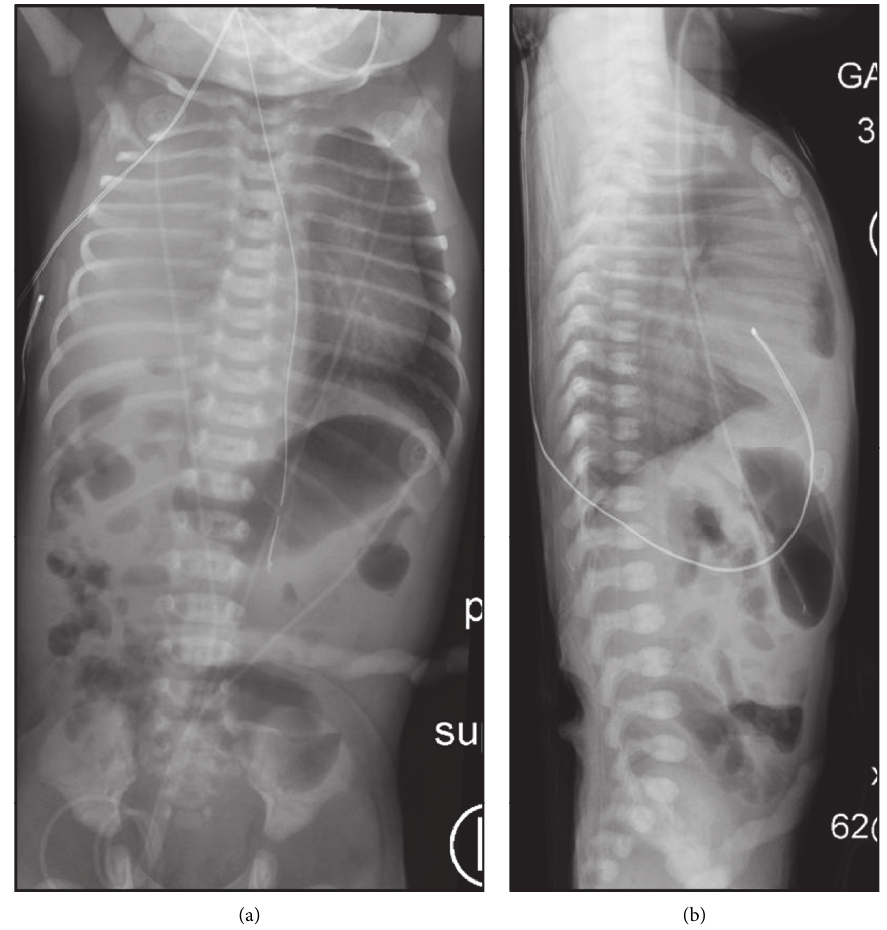
Figure 1: Radiographs upon admission. (a) Anterior-posterior view depicting complete opacification of right hemithorax with leftward mediastinal shift. (b) Cross-table lateral view depicting suspected hernia of abdominal contents into chest